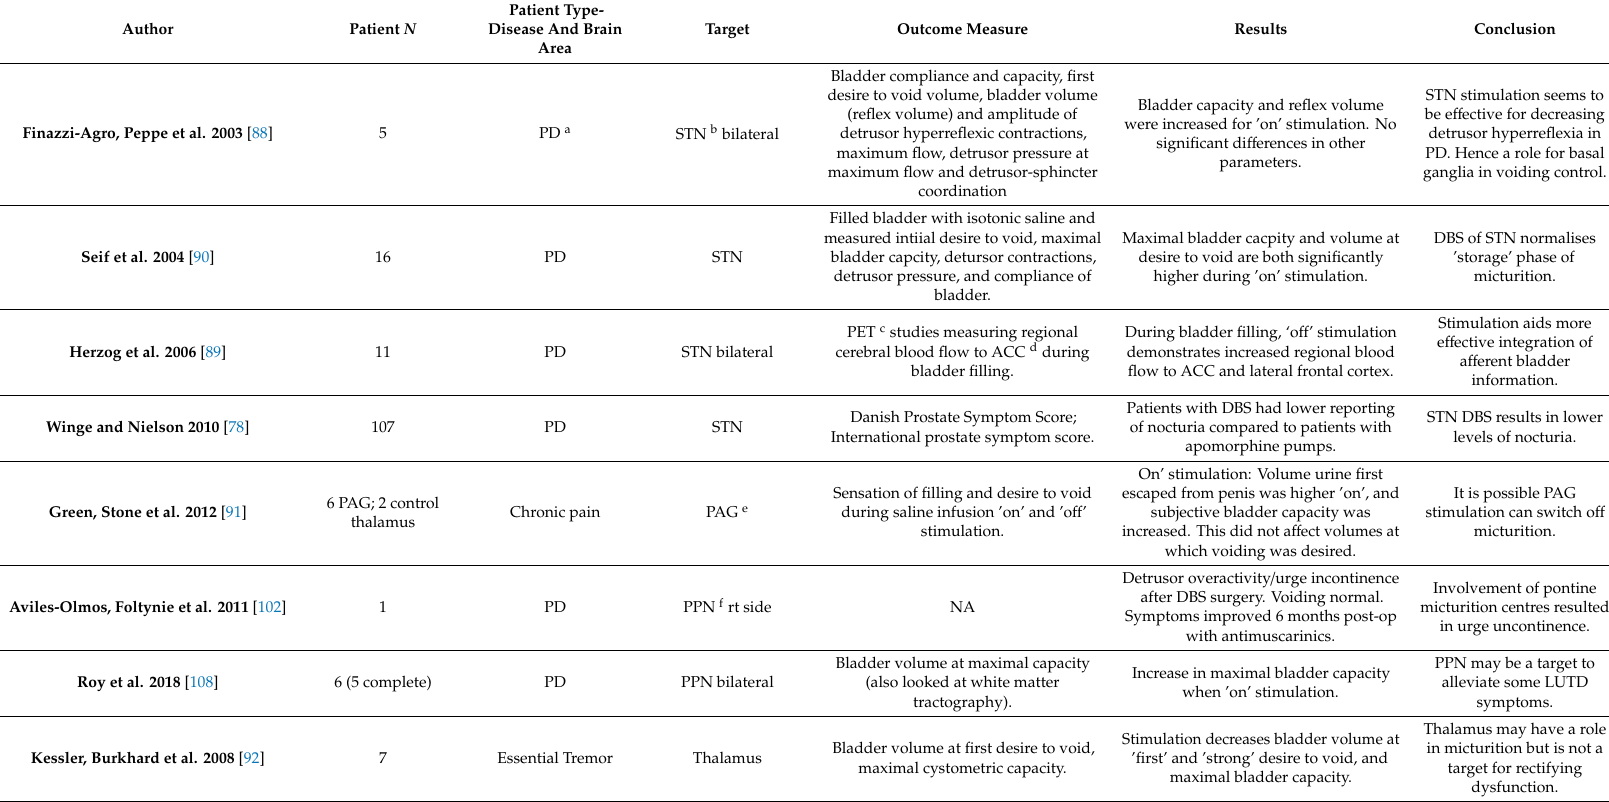
Table 4. Key Studies surrounding DBS and